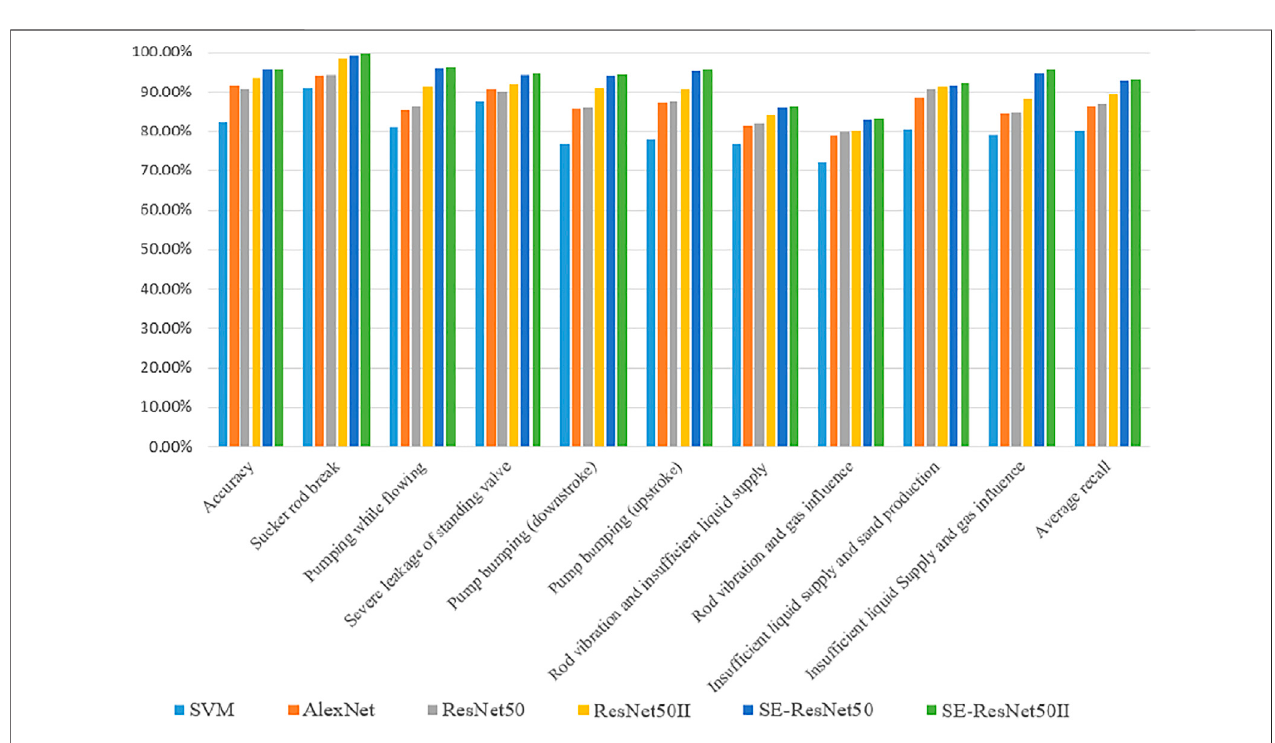
FIGURE 10 | Accuracy and recall of different models.